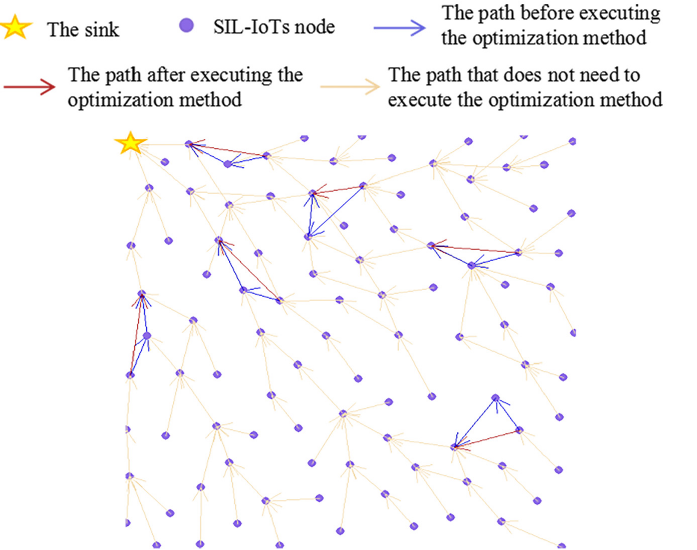
Figure 11. During the simulation of THECB, some path-circle situations appear. After executing the optimization method, paths have the least number of